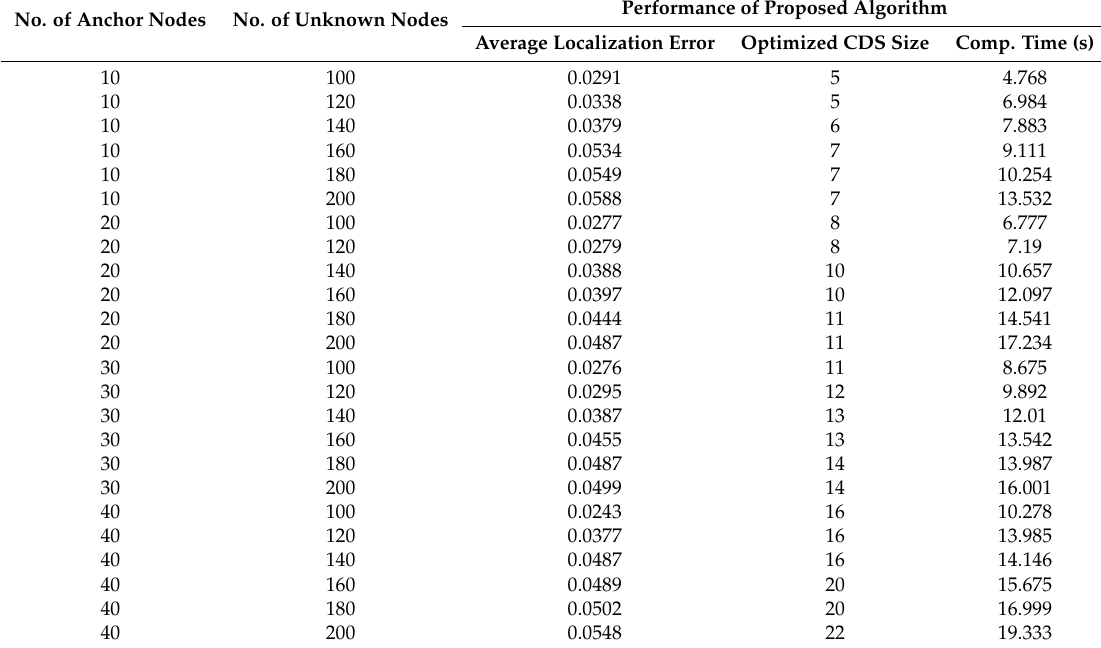
Table 3. Statistical values of